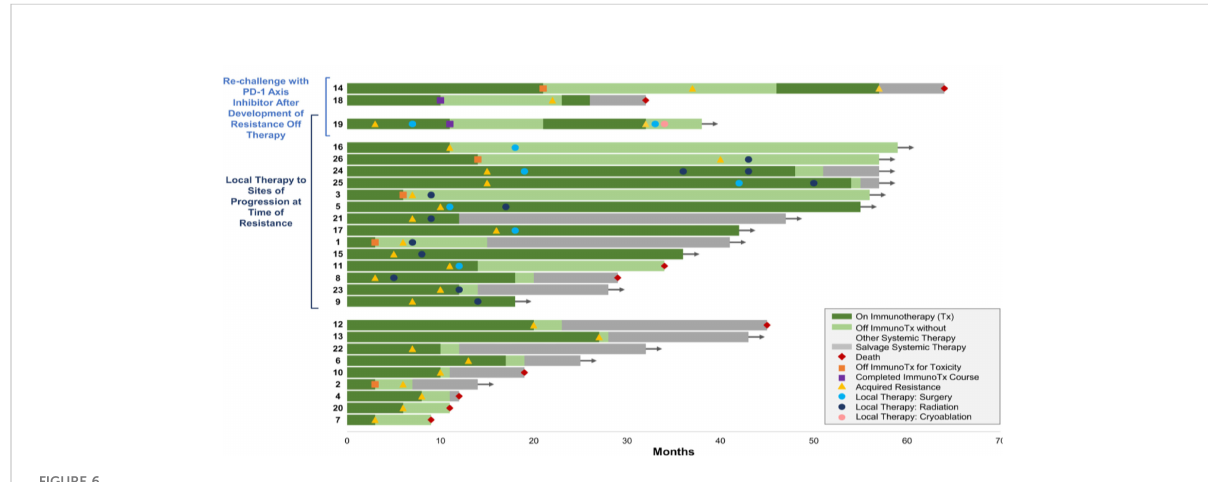
FIGURE 6 Treatment and resistance